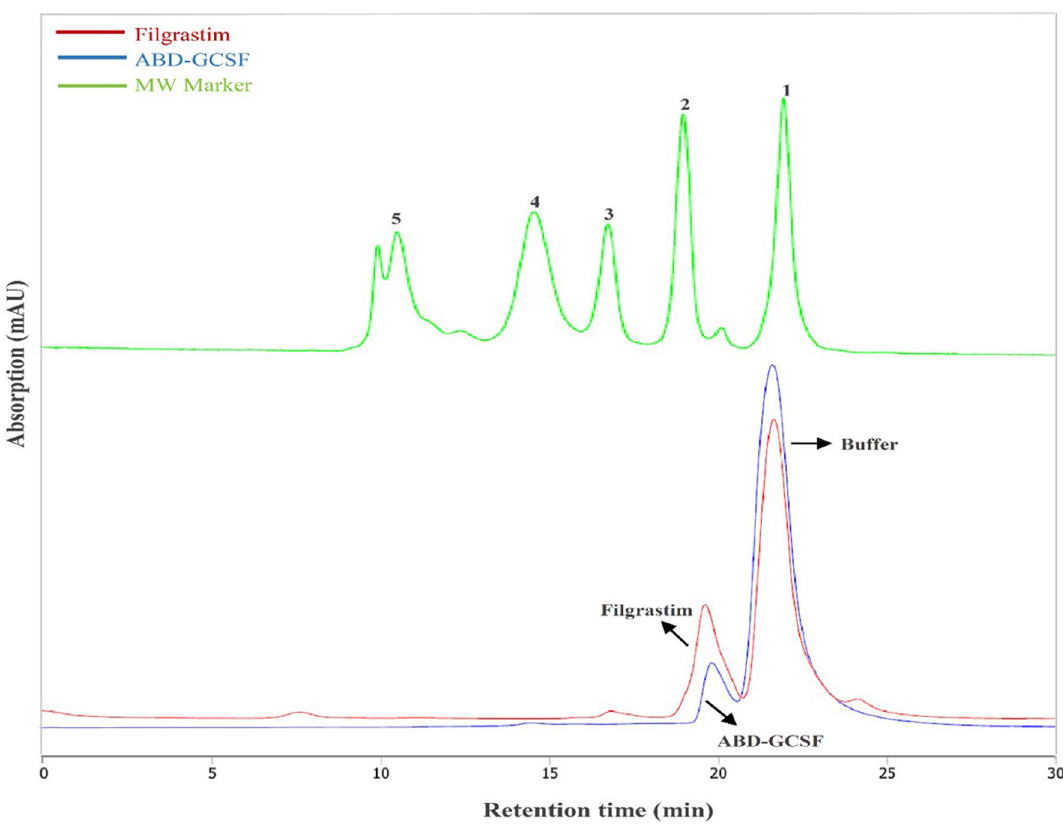
Figure 3. Size exclusion chromatography of Filgrastim and ABD-GCSF. Molecular weight marker includes the following proteins: (1) vitamin B12 (1.350 kDa); (2) horse myoglobin (17 kDa); (3) chicken ovalbumin (44 kDa);